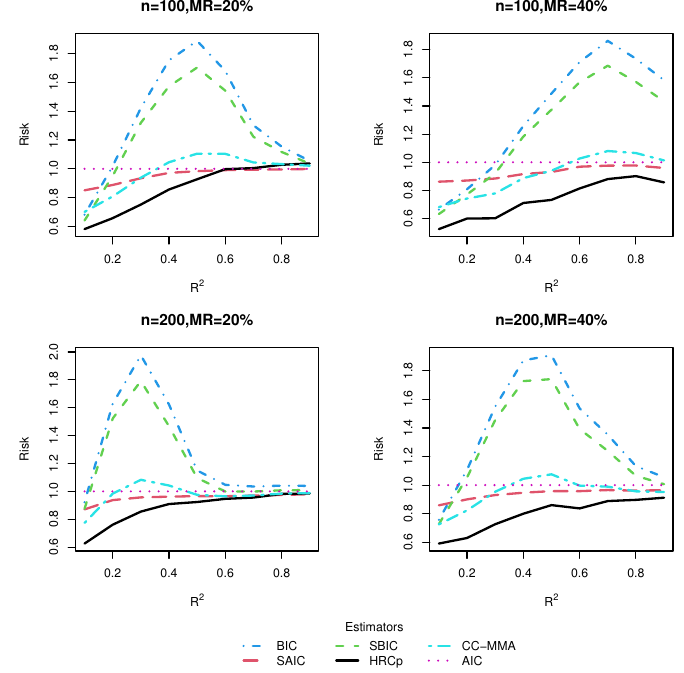
Figure 5. Risk comparisons for Design 3.